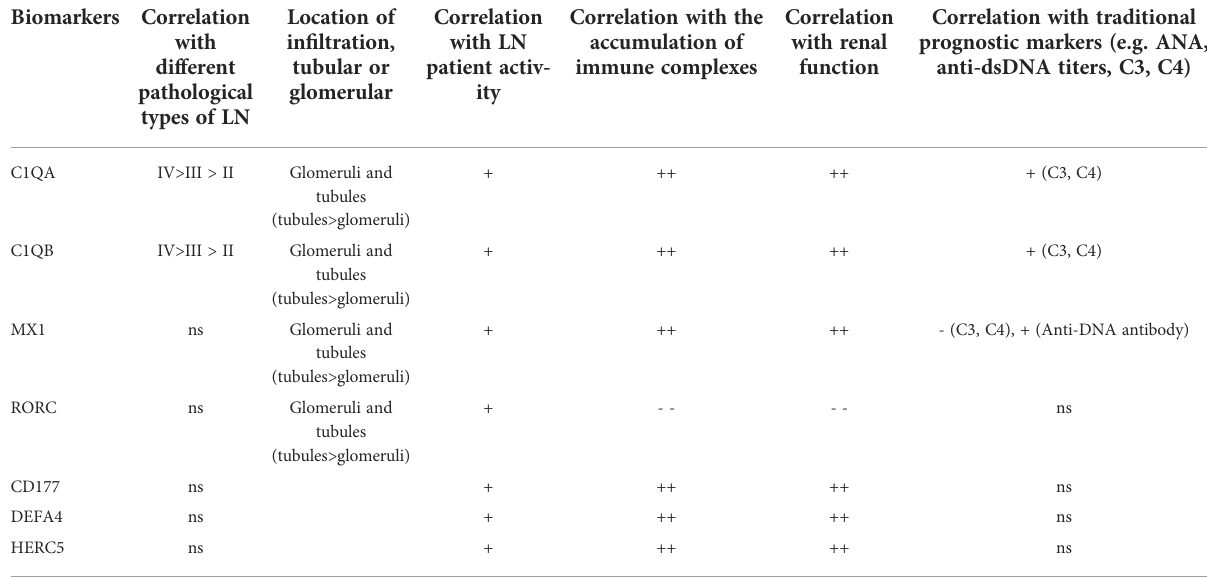
TABLE 1 Summary of biomarkers and clinicopathological features. Biomarkers Correlation with